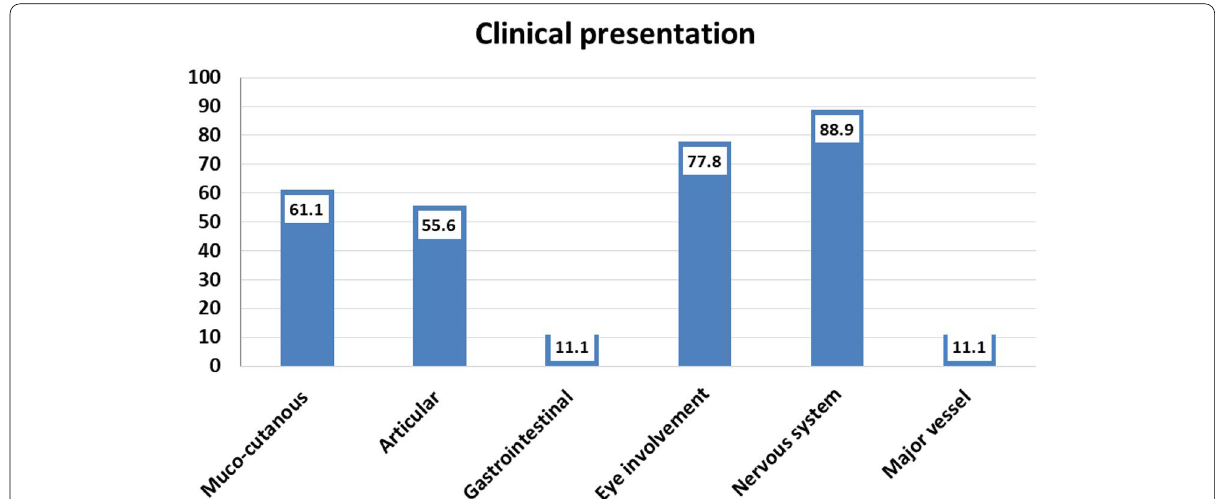
Fig. 1 Bar graph showing the incidence of different clinical manifestations among the studied cases. Data are represented as %